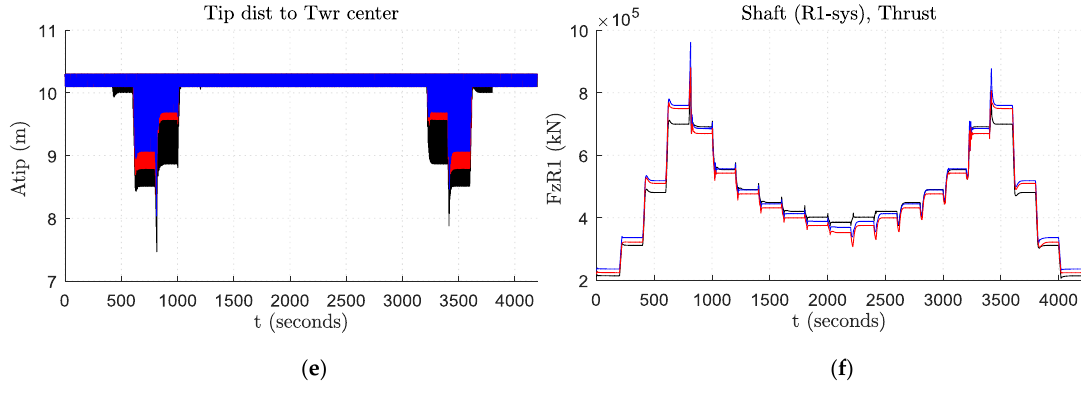
Figure 7. OffWindChina 5 MW performance (Optimum) compared to the baseline and the NREL 5 MW for an increasing and a decreasing wind speed simulation. ( a ) Wind speed at hub height; ( b ) electrical power; ( c ) rotor speed; ( d ) pitch angle; ( e ) tip distance to tower center; and ( f ) shaft thrust.